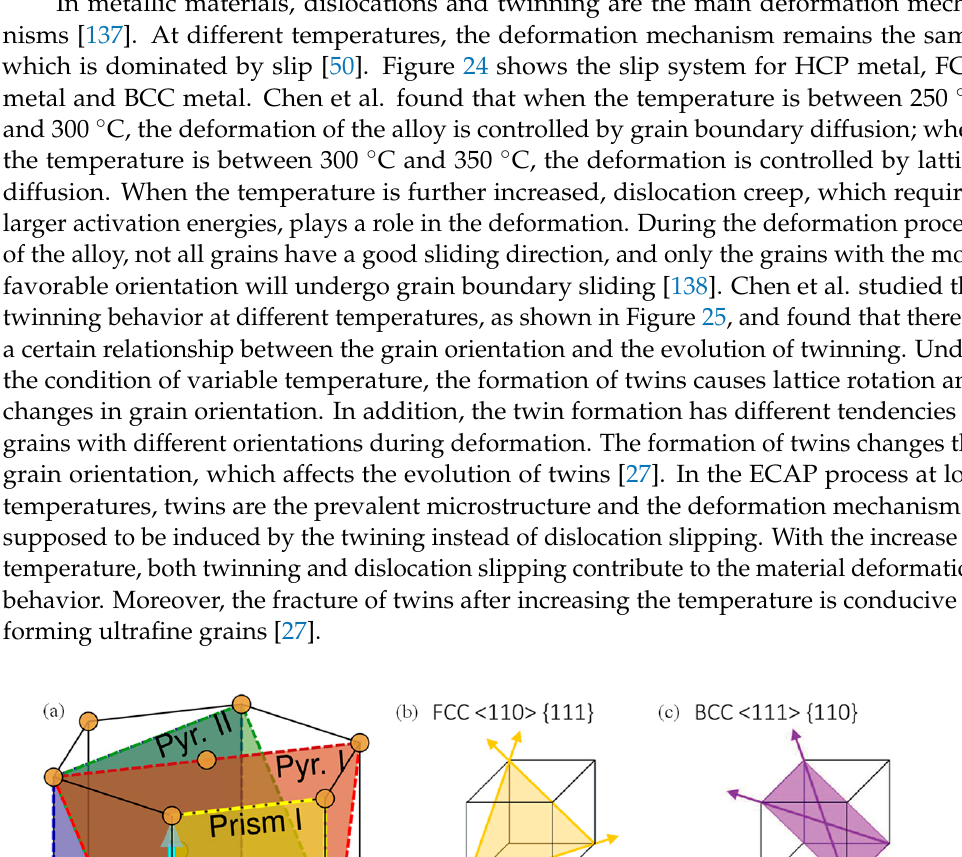
20 of 31 Figure 23. TEM images of annealing at different temperatures after 8 passes of ECAP [135]: ( a , d ) 393